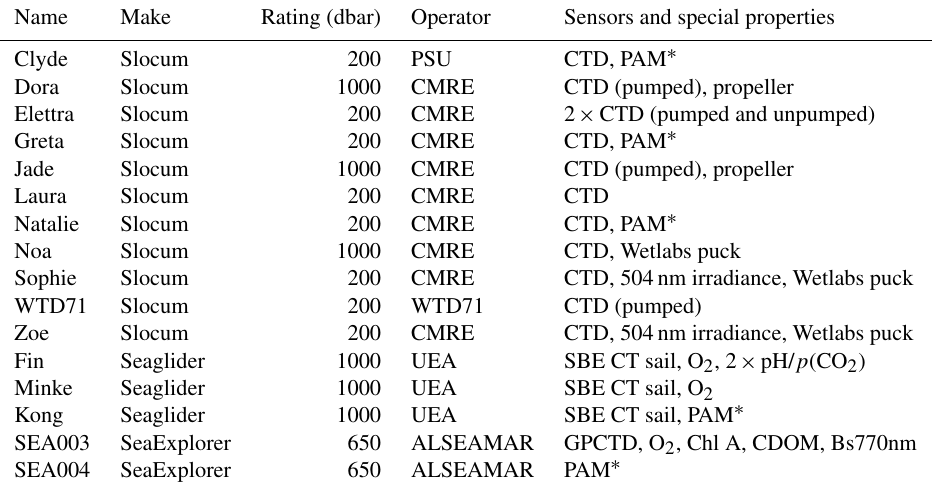
Table 3. Specifications of the gliders provided for the experiment. Greta, Natalie, and SEA004 were deployed only during Leg 2 within the framework of the acoustic experiments; Laura and Sophie served as backup. For the specifications of most sensors, see the websites of the manufacturers in Sect. 2.